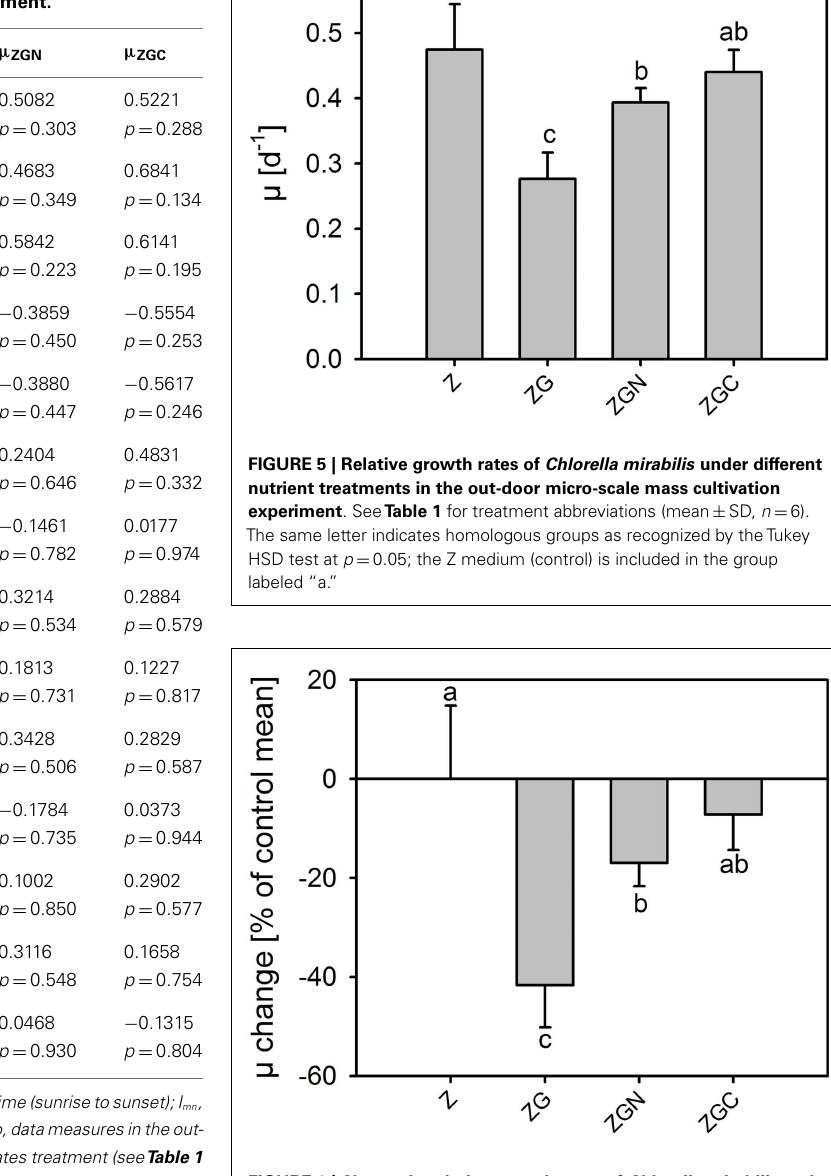
FIGURE 6 | Change in relative growth rates of Chlorella mirabilis under different nutrient treatments in the out-door micro-scale mass cultivation experiment .The values were normalized to the control mean (100%).The zero line corresponds to 100% of the control. See Table 1 for treatment abbreviations (mean ± SD, n = 6).The same letter indicates homologous groups as recognized by theTukey HSD test at p = 0.05; the Z medium (control) is included in the group labeled